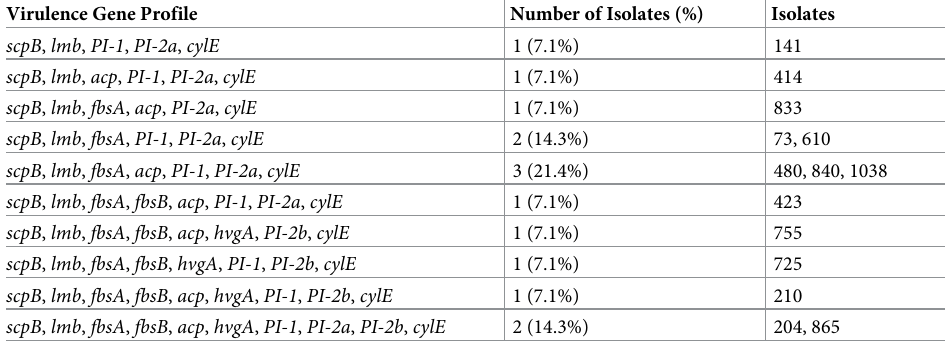
Table 7. Virulence gene profiles of 14 group B Streptococcus isolated from pregnant